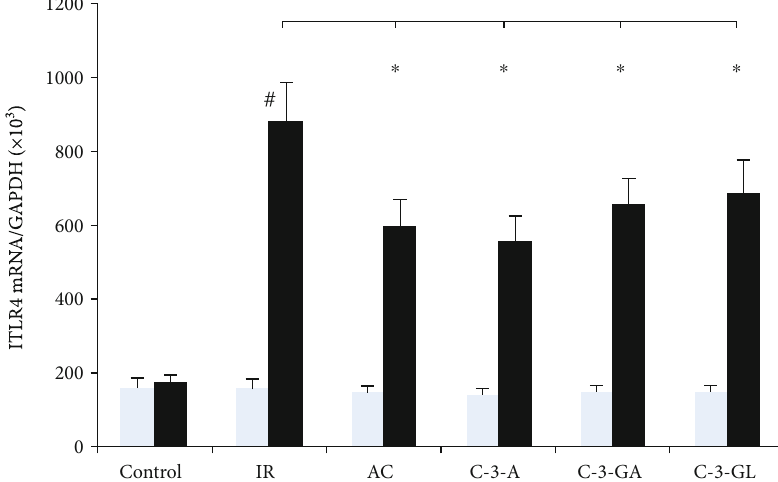
Figure 8: TLR4 mRNA expression in the kidney of the renal IR injury and anthocyanin treatment. TLR4: toll-like receptor 4. The data are the means ± SD . n = 13 per group. IR: ischemia/reperfusion; AC: anthocyanins; C-3-A: cyanidin-3-arabinoside; C-3-G: cyanidin-3-glucodise; C- 3-GA: cyanidin-3-galactoside. The comparison between treated mice and IR was indicated by asterisks. # P < 0 : 01 vs. control within group; ∗ P < 0 : 05 vs. respective IR group.